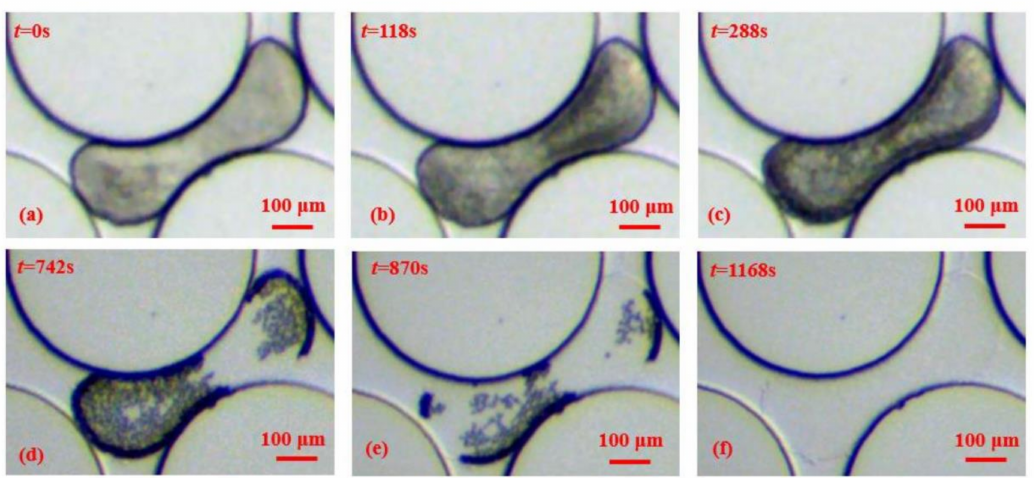
Figure 7. The morphological evolution of film thickening growth in pores at different times ( a – f